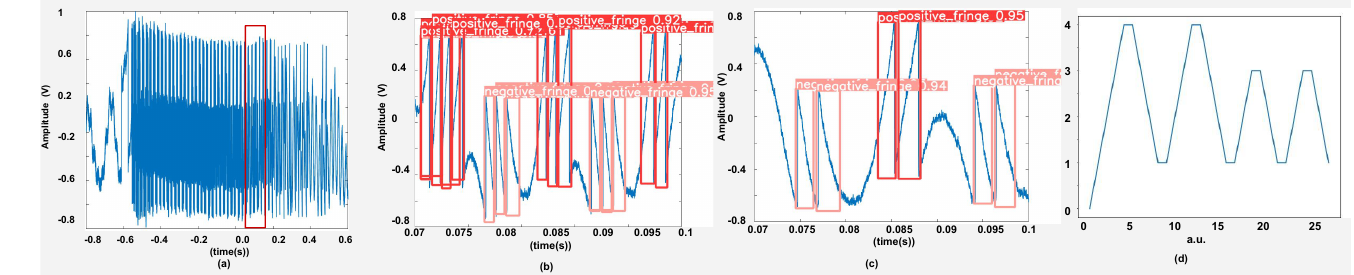
Figure 10. Displacement reconstruction for 2 segments of an experimental SMI signal: ( a ) experimen- tal signal, ( b , c ) show two consecutive segments of the signal located in the red rectangular box of ( a ), and ( d ) shows the reconstructed displacement based on labels provided by the DNN.